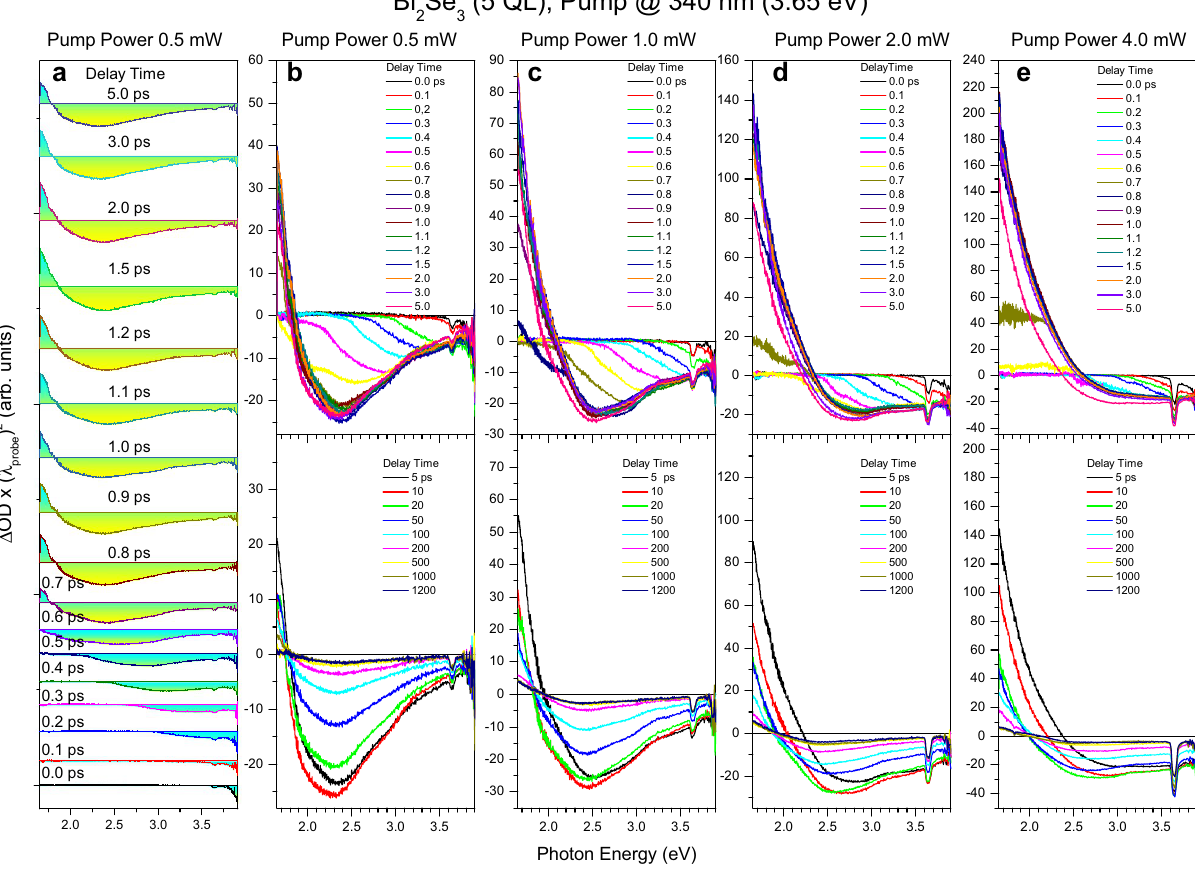
Figure 2. TA spectra of the gapped topologically nontrivial insulator phase of the 2D TI Bi 2 Se 3 . ( a – e ) Set of TA spectra of the 5 QL thick Bi 2 Se 3 film measured at delay times indicated by the corresponding colors using the ∼ 340 nm pumping ( ∼ 3.65 eV photon energy) of different powers, as indicated for each of the columns. Part ( a ) and ( b ) show the same TA spectra for clarity. The zero-intensity lines of TA spectra in part ( a ) were shifted along the ΔOD axis (optical density change) for better observation. The factor (λ probe ) 2 in the ΔOD axis arises due to wavelength-to-energy units’